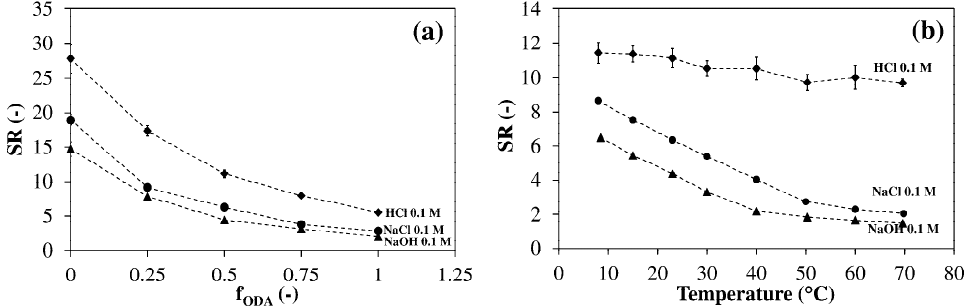
Figure 10. Effect of the pH on the swelling behavior. ( a ) Dependence of the room temperature swelling ratio from f ODA . ( b ) Swelling ratio vs. temperature for the hydrogel with f ODA = 0.50. Each datum represents the average of four replicates.